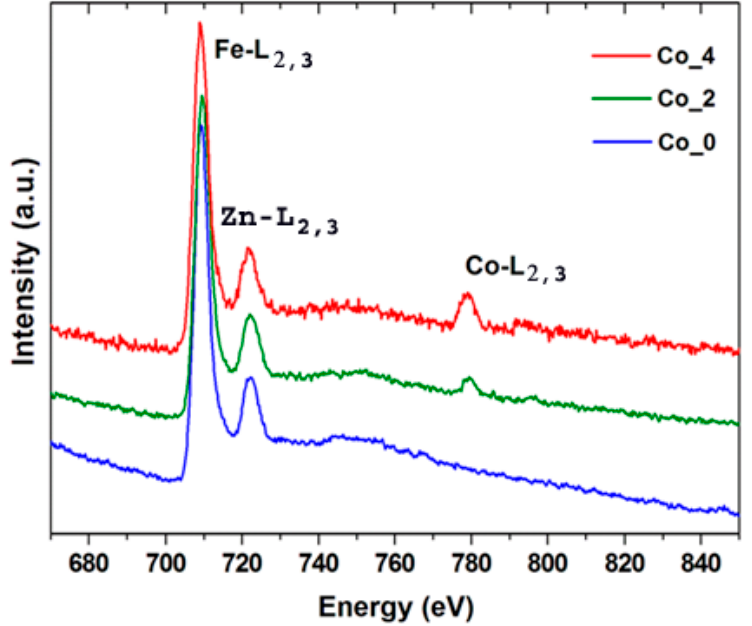
Figure 5. EELS spectra for Co_0 , Co_2 and Co_4 samples.